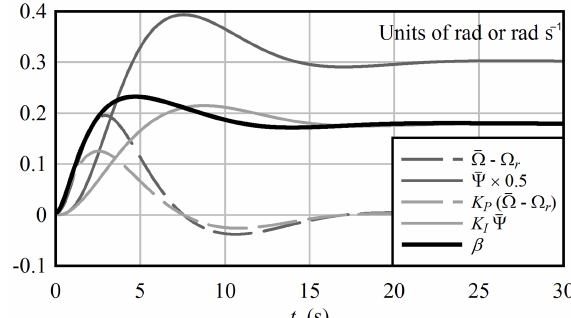
Figure 9. Startup of a simulation at a wind speed of 15ms − 1 , showing how the steady-state blade pitch angle is set by the integral pathway. The perceptible lag between the integrated speed error, and the integral pathway’s contribution to the blade pitch command, hints at the problem with scheduling the gain outside the integral of the speed